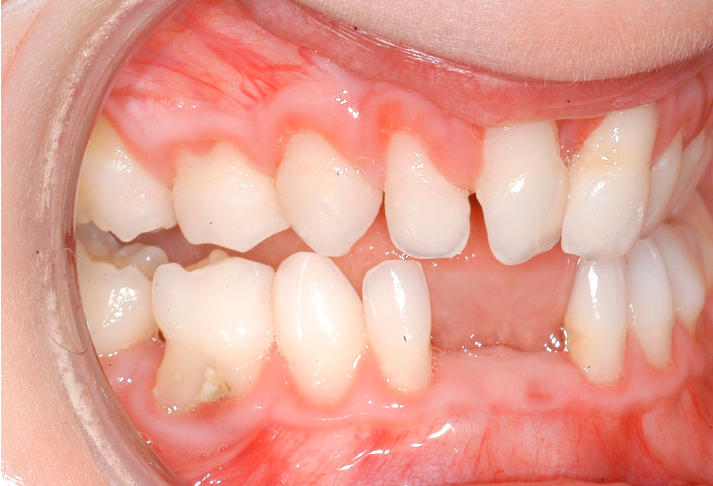
Figure 6. Five-year-old girl with Ehlers–Danlos Syndrome and periodontal destruction.